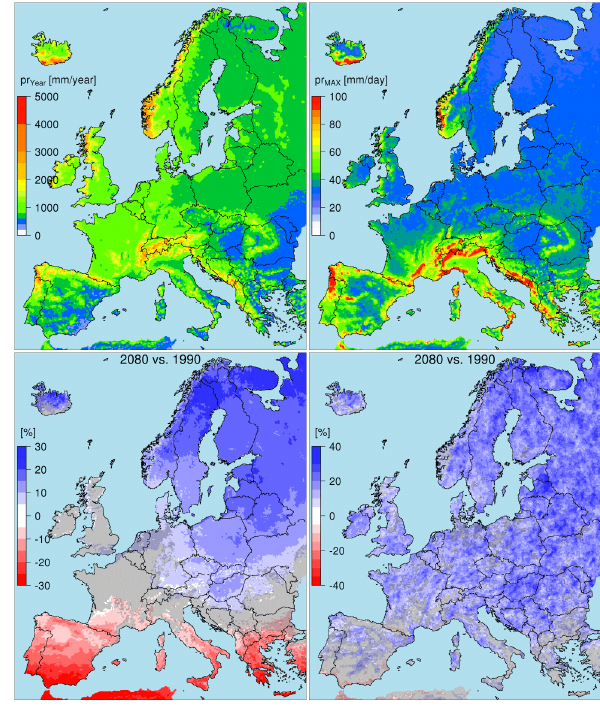
Figure 4. Annual precipitation (pr Year , left) and annual maximum daily precipitation (pr MAX , right). Ensemble mean of the baseline (top) and relative change for the time slice 2066–2095 (bottom). Data points with CV > 1 are greyed